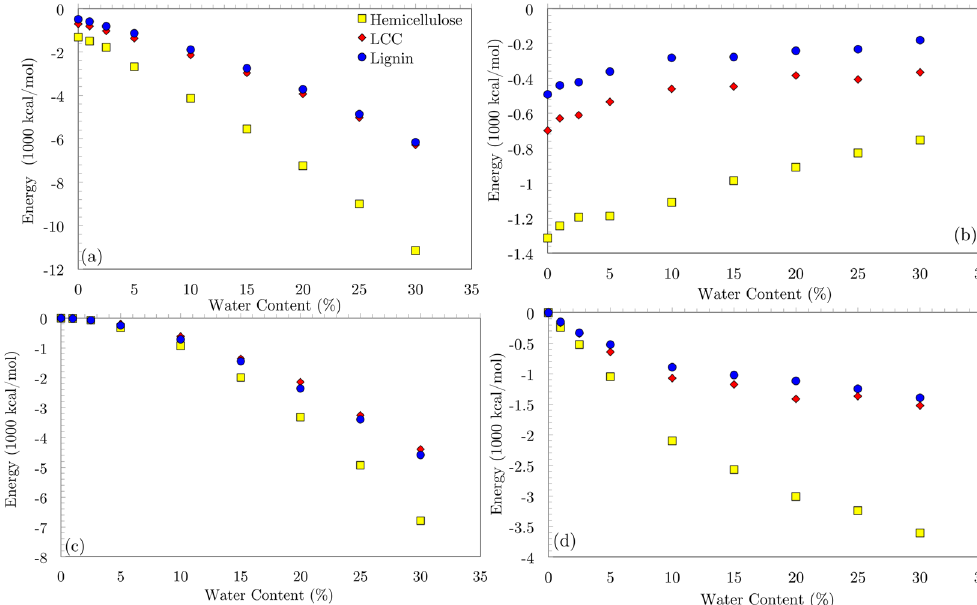
Figure 4. Hemicellulose, lignin and LCC variation of hydrogen bond energies ( a ) between all particles ( b ) between just polymer chains ( c ) between just water molecules ( d ) between polymer chains and water molecules. At lower than 10% MC, while hydrogen bond between polymer chains are broken by water molecules, they are being replaced by hydrogen bonds between water molecules and polymer chains. At more than 10% MC, water molecules tend to form hydrogen bonds with other water molecules and create nano-droplets in the